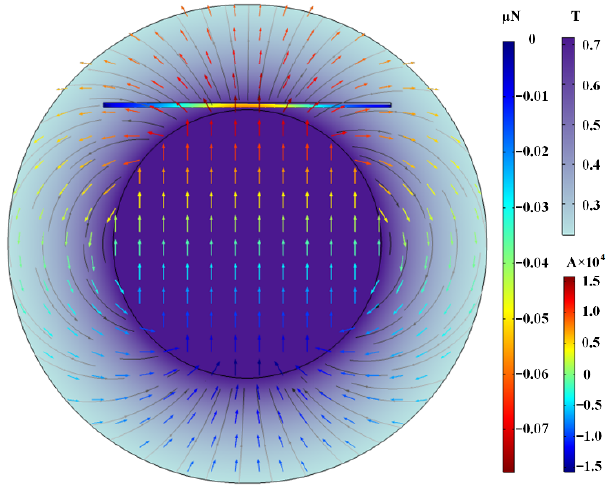
Figure 4. Entire 2D simulation